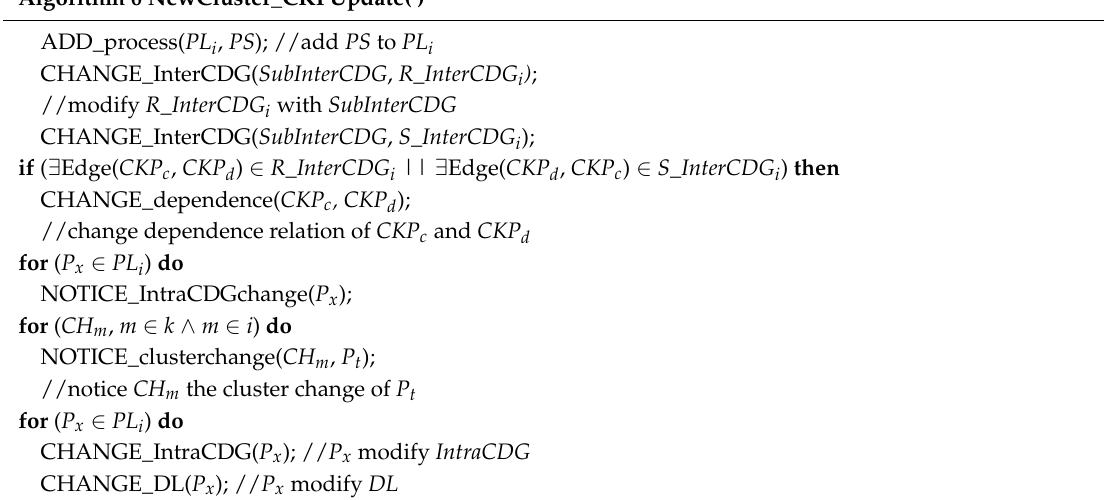
Algorithm 6 NewCluster_CKPUpdate( )